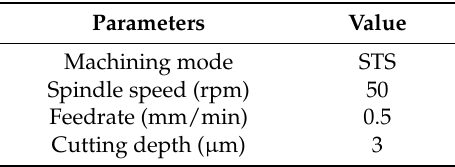
Table 2. Machining variables for sinusoidal grid